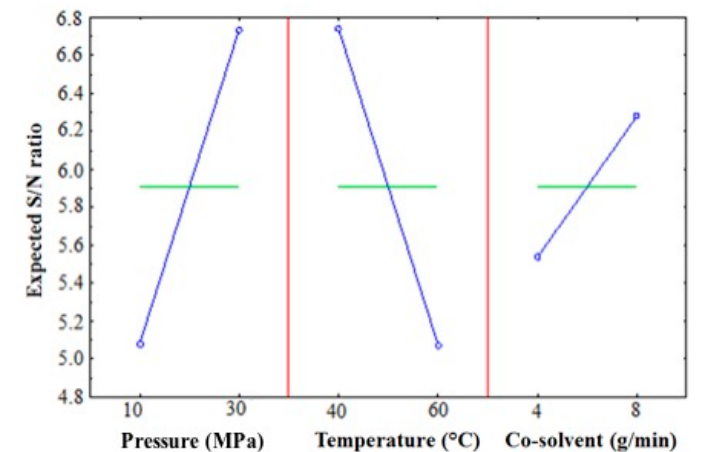
Figure 1. Results of the Taguchi experiment to identify the most influential factors on the extraction yield (%) of Mexican arnica. Higher signal to noise ratio (S/N) indicates higher influence on the extraction yield by means of supercritical CO 2 . Blue lines represent the size of the effect, green lines represent the optimal S/N ratio.